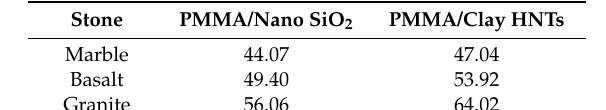
Table 1. The maximum values of Rockwell hardness (HRC) obtained for PMMA nanocomposites entrapped with stone sludge fillers (SSF).